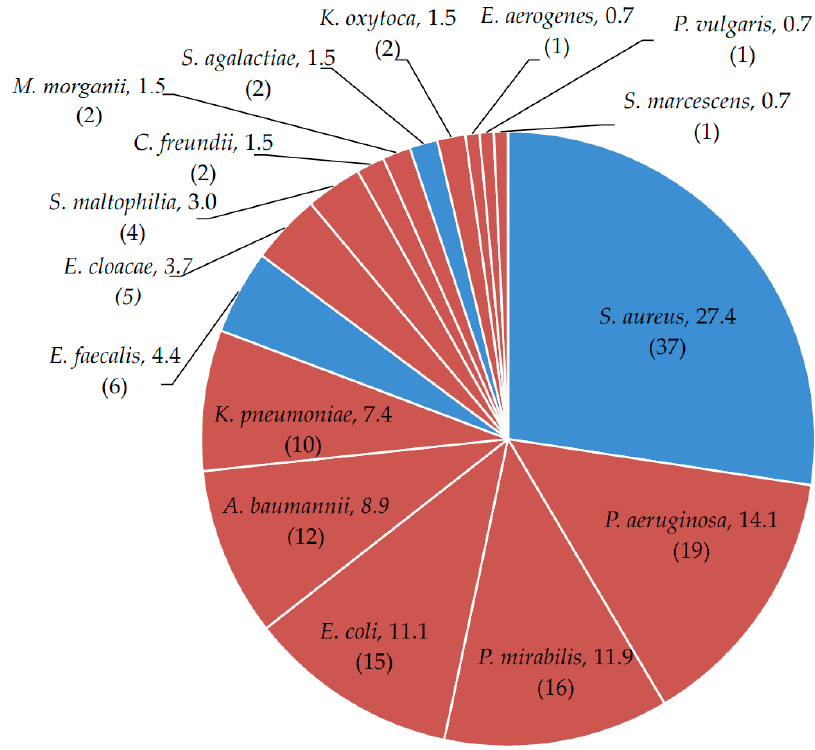
Figure 1. Bacterial isolates from patients with colonized skin ulcers: Staphylococcus aureus , Pseudomonas aeruginosa , Proteus mirabilis , Escherichia coli , Acinetobacter baumannii , Klebsiella pneumonia , Enterococcus faecalis , Enterobacter cloacae , Stenotrophomonas maltophilia , Citrobacter freundii , Morganella morganii , Streptococcus agalactiae , Klebsiella oxytoca , Enterobacter aerogenes , Proteus vulgaris and Serratia marcescens . Data in percentage. In brackets, the absolute occurrence of different bacterial species. Blue = Gram-positive; red = Gram-negative.